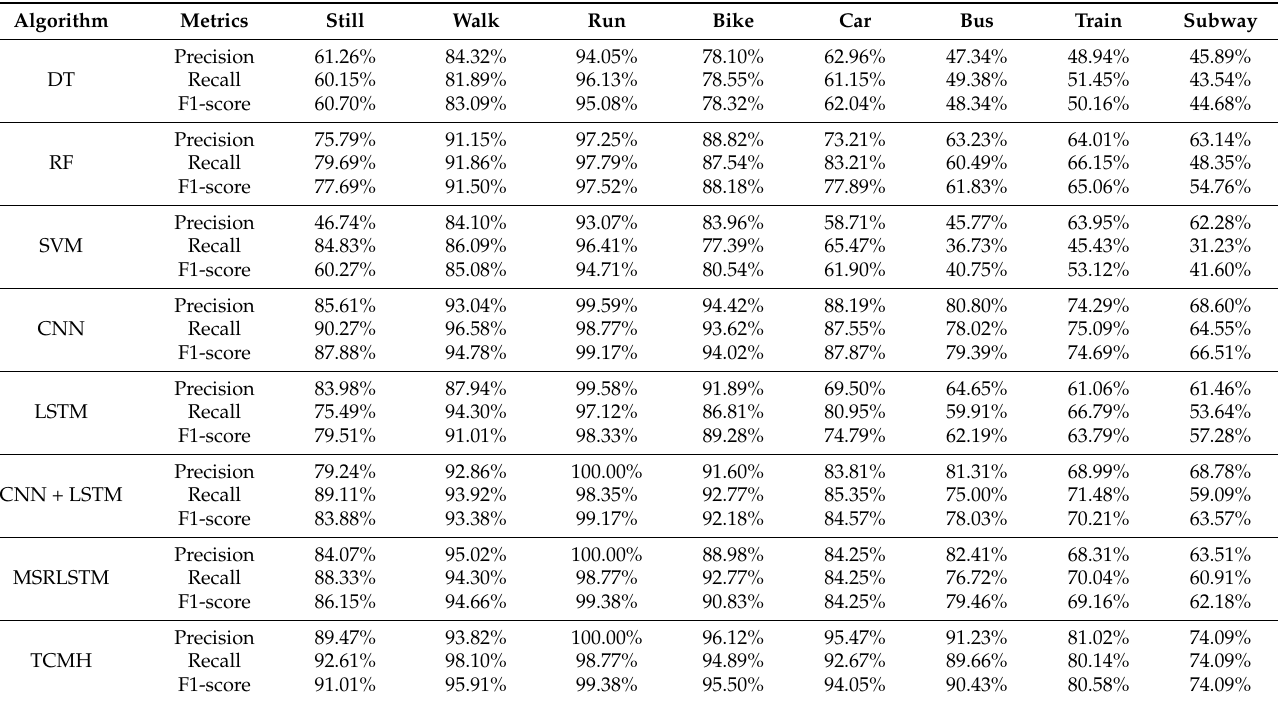
Table 3. Comparison of evaluation metrics of different algorithms on the SHL dataset.